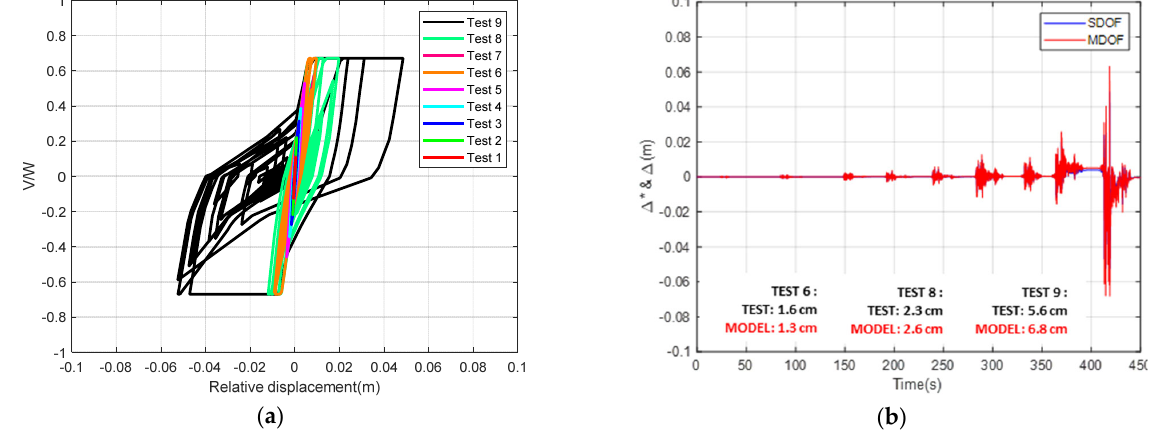
Figure 10. Equivalent SDOF modelling. ( a ) load − displacement relation, ( b ) roof displacement re ‐ sponse histories. response